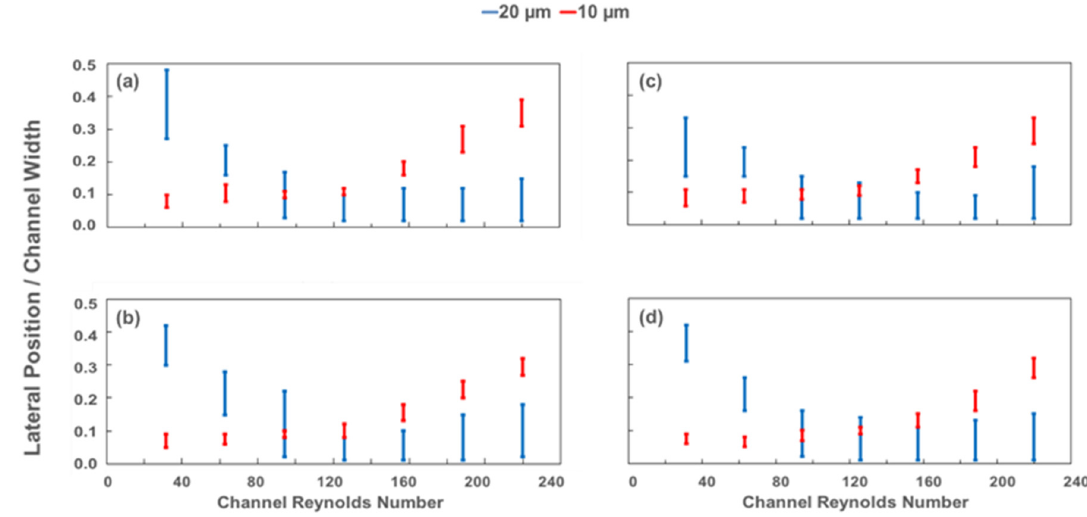
Figure 5. Lateral focusing position from the inside wall normalized by the channel exit width of 1 mm for ( a ) Case 1, ( b ) Case 2, ( c ) Case 3, and ( d ) Case 4 at the outlet. for ( a ) Case 1, ( b ) Case 2, ( c ) Case 3, and ( d ) Case 4 at the